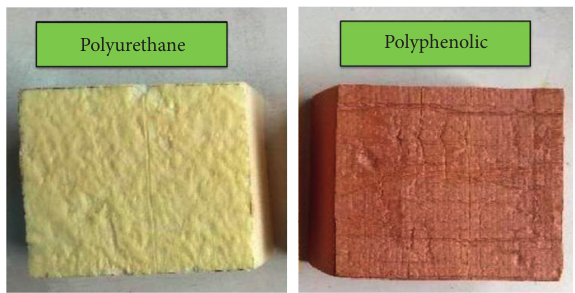
Figure 1: Insulation material samples.